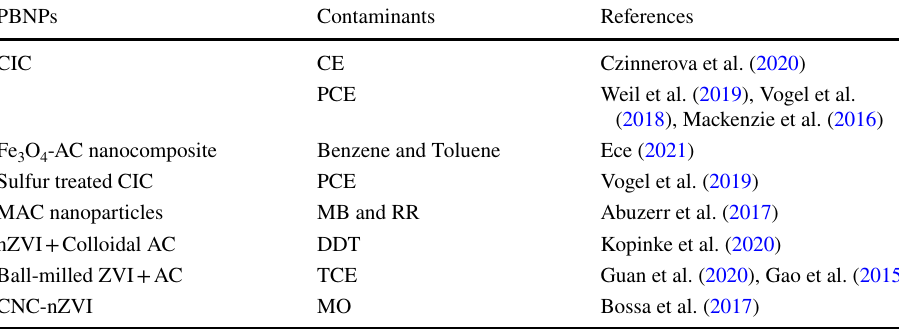
Table 2 An overview of recent Fe/AC nanoparticle studies on the adsorption of organic